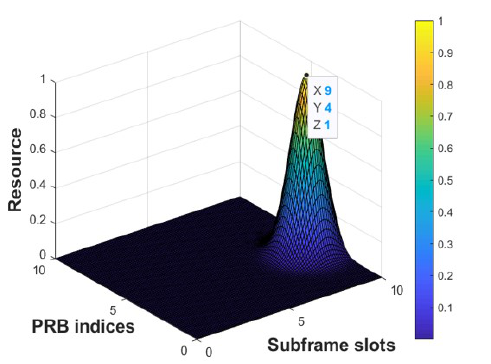
Figure 9. Available and allocated resources.